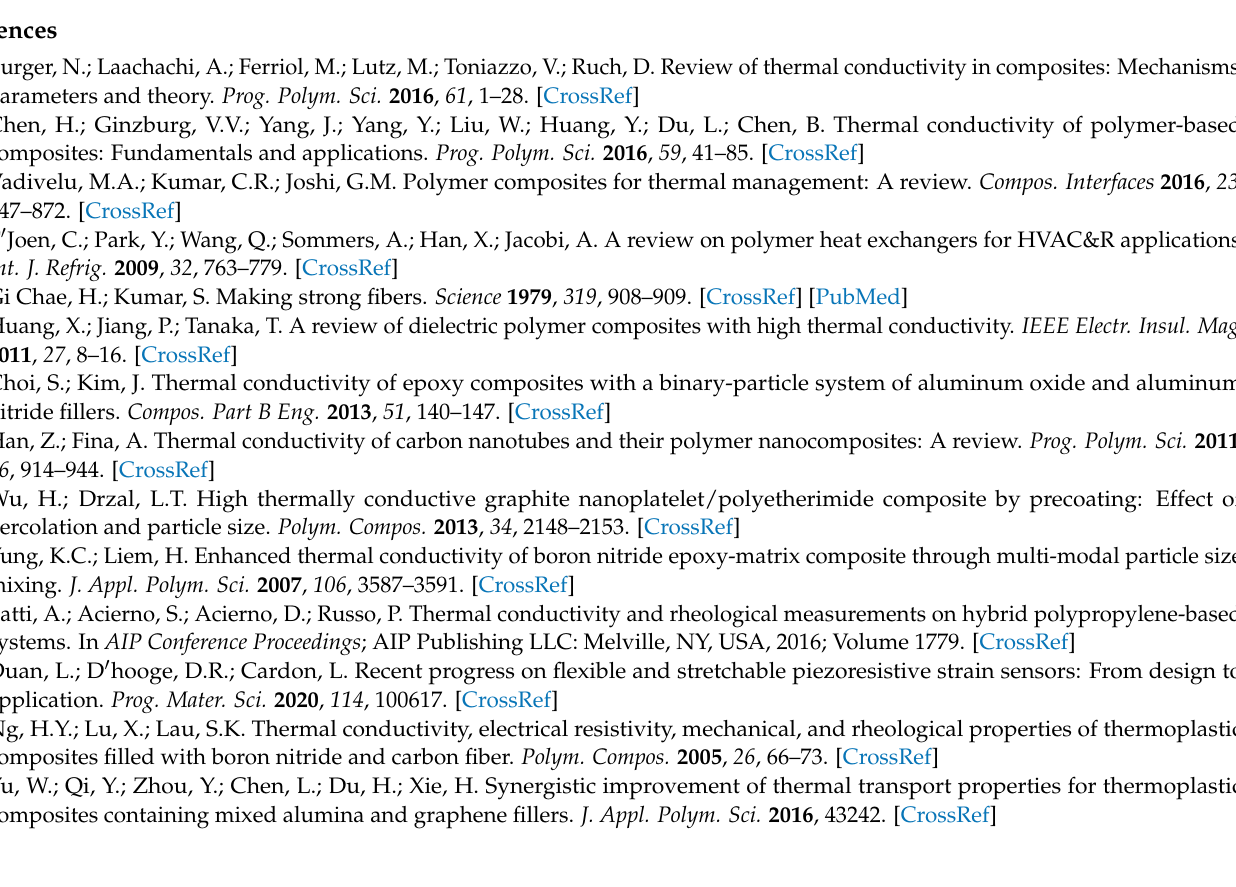
Figure S2: ANOVA results; (a) ANOVA results for the TC FCCD (b) ANOVA results for the melt viscosity FCCD; Table S1: Determination of the dominant filler for the viscosity increase; Table S2: Densities of the polymer and